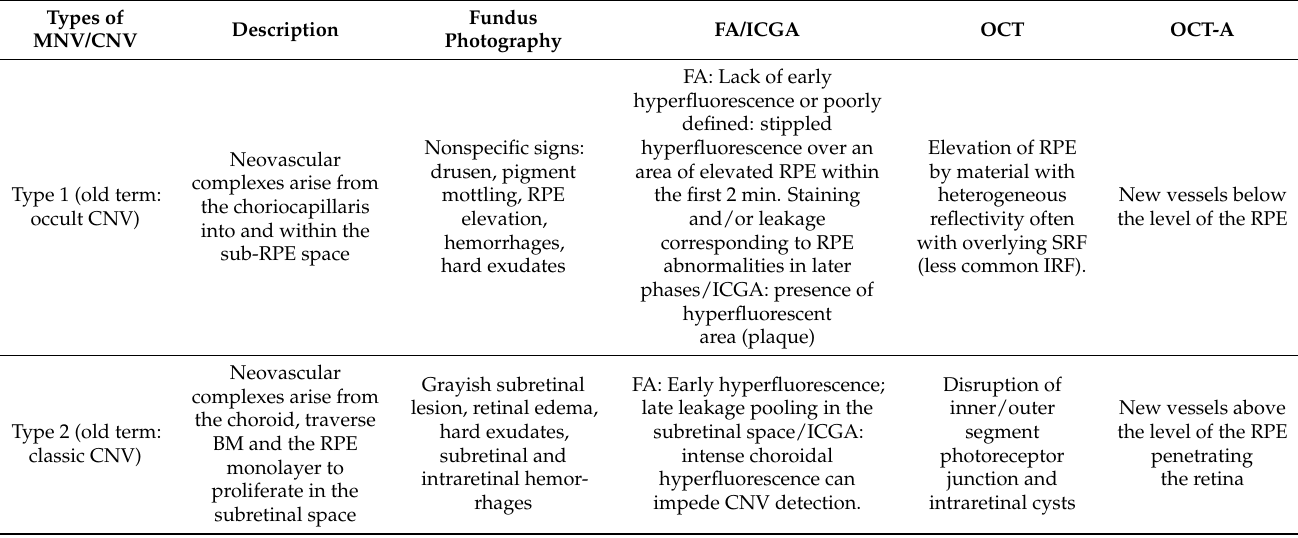
Table 1. Types of neovascularization in